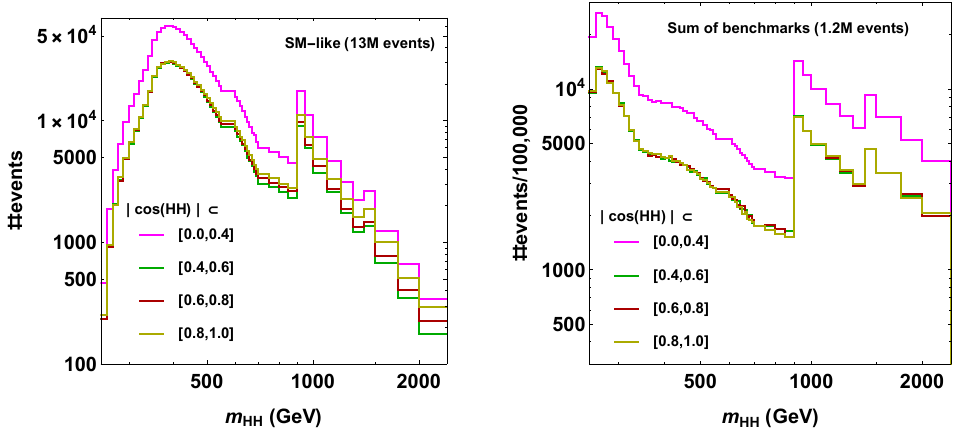
Figure 19 . The bin-by-bin statistic of events in a 13M SM sample and a 1.2M reweighting sample constructed by the plain sum of shape